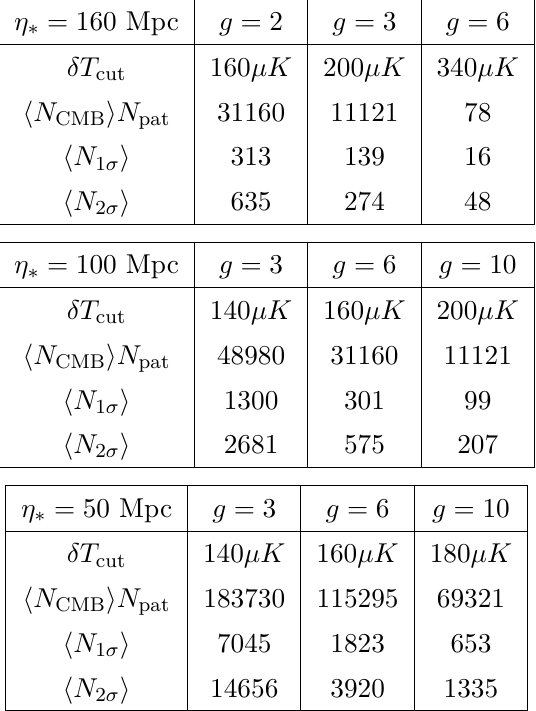
Table 1 . Optimized δT cut values for each benchmark scenario, along with the number of background events h N and the number of injected hotspot pairs to a achieve 1 or 2 σ excess following CMB i N pat the eq. (4.4) ( h N 1 σ i , h N 2 σ i